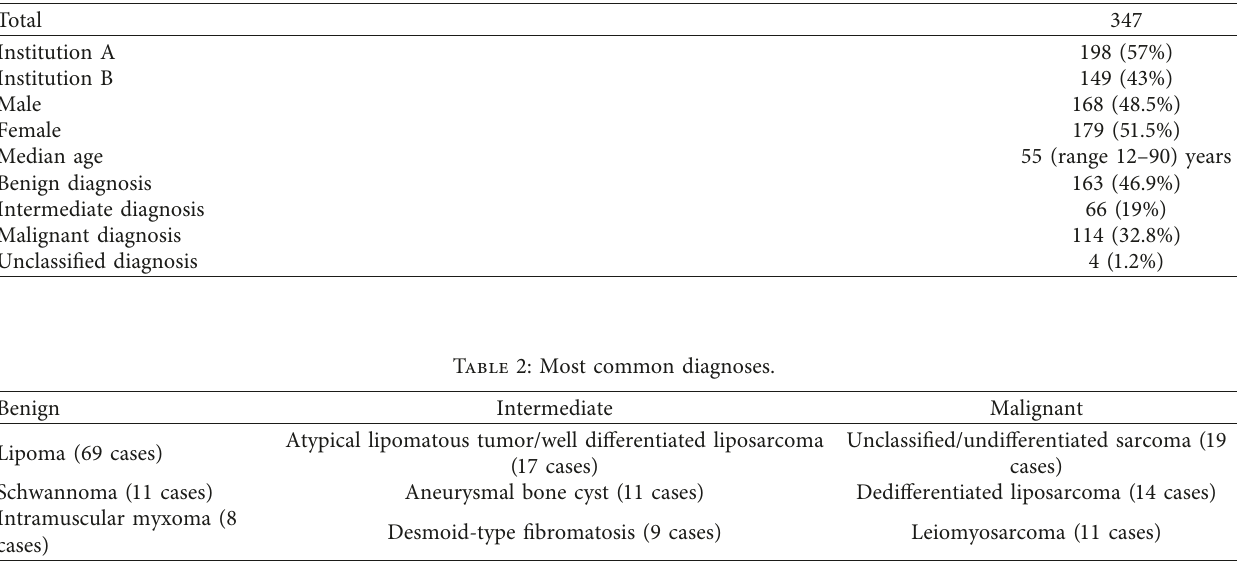
Table 1: Patient and tumor characteristics.